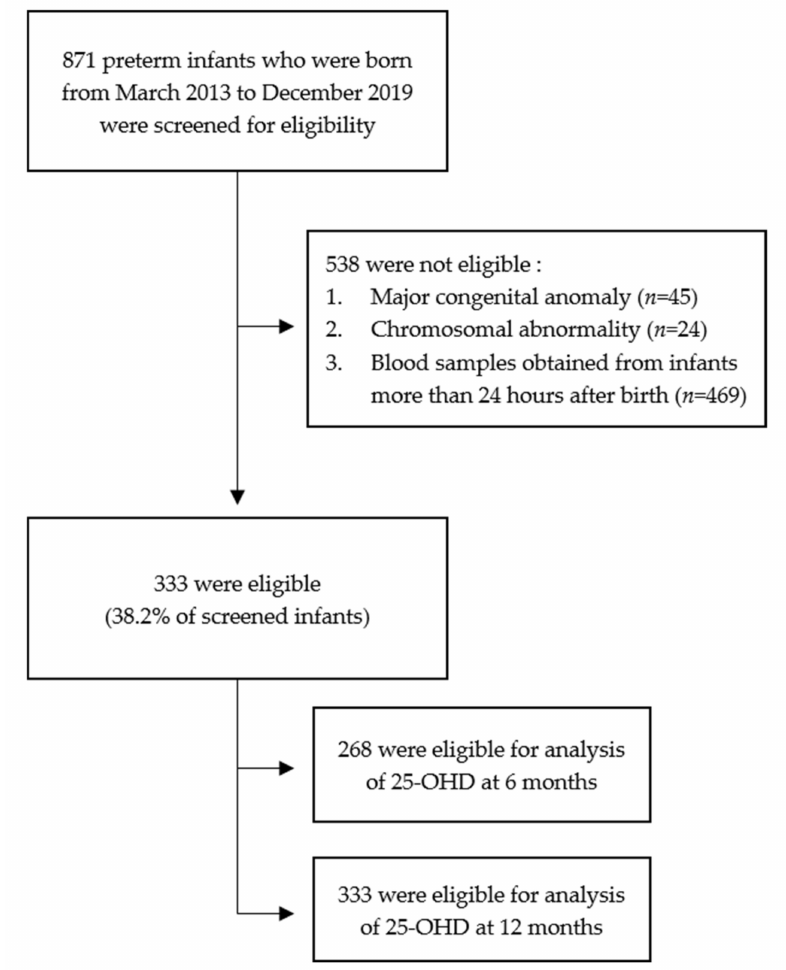
Figure 1. Flow chart of the study